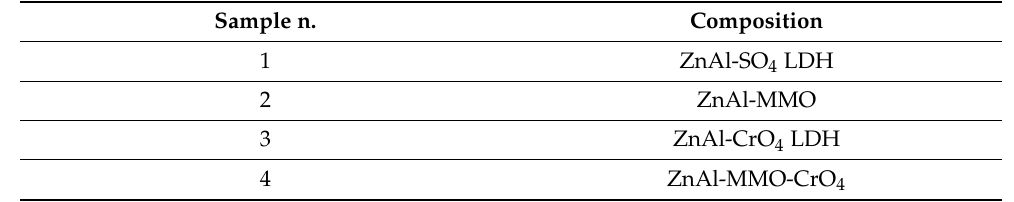
Table 1. Scheme of the substrates used in the present tests concerning photocatalytic abatement of contaminants. Sample